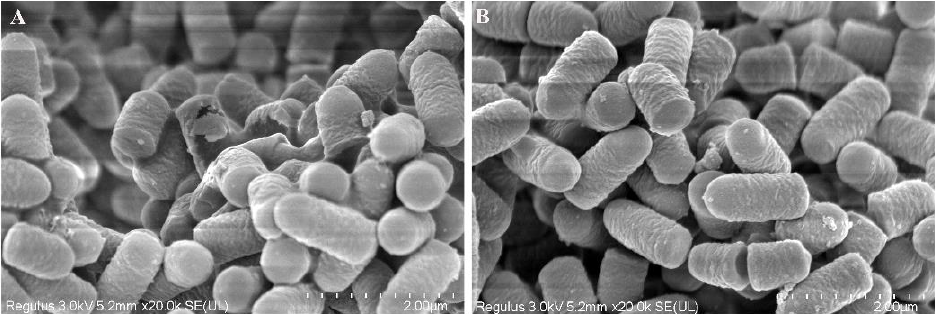
Figure 5. Scanning electron microscopy of lyophilized L. plantarum N8 powder: ( A ) ordinary mMRS culture; ( B ) Tween 80, β -carotene, and melatonin added to culture media.